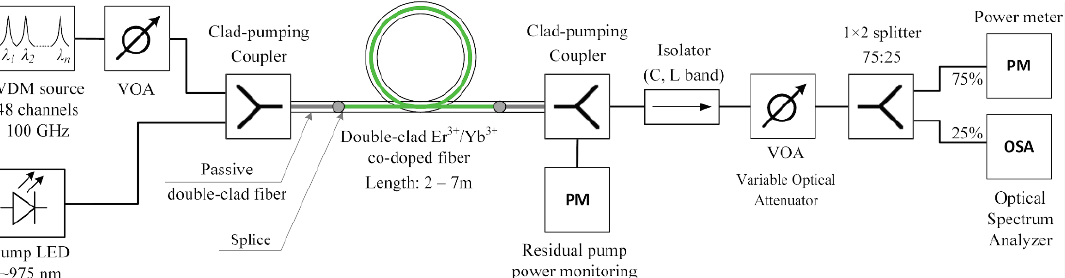
Figure 5. Simplified simulation setup of the cladding-pumped EYDFA.